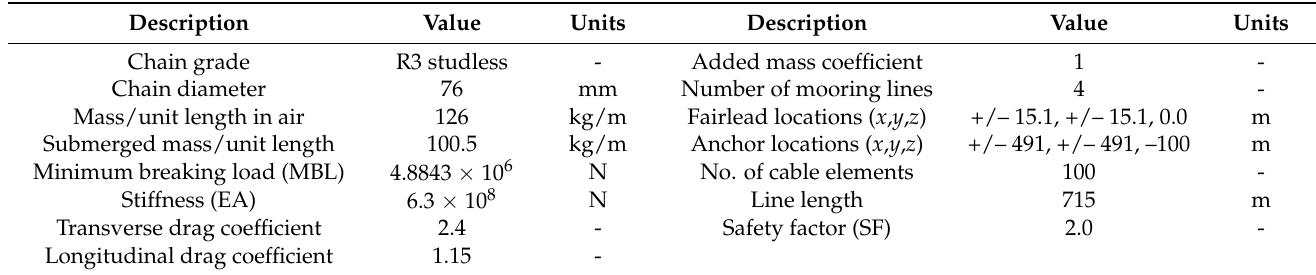
Table 7. FOWC catenary mooring